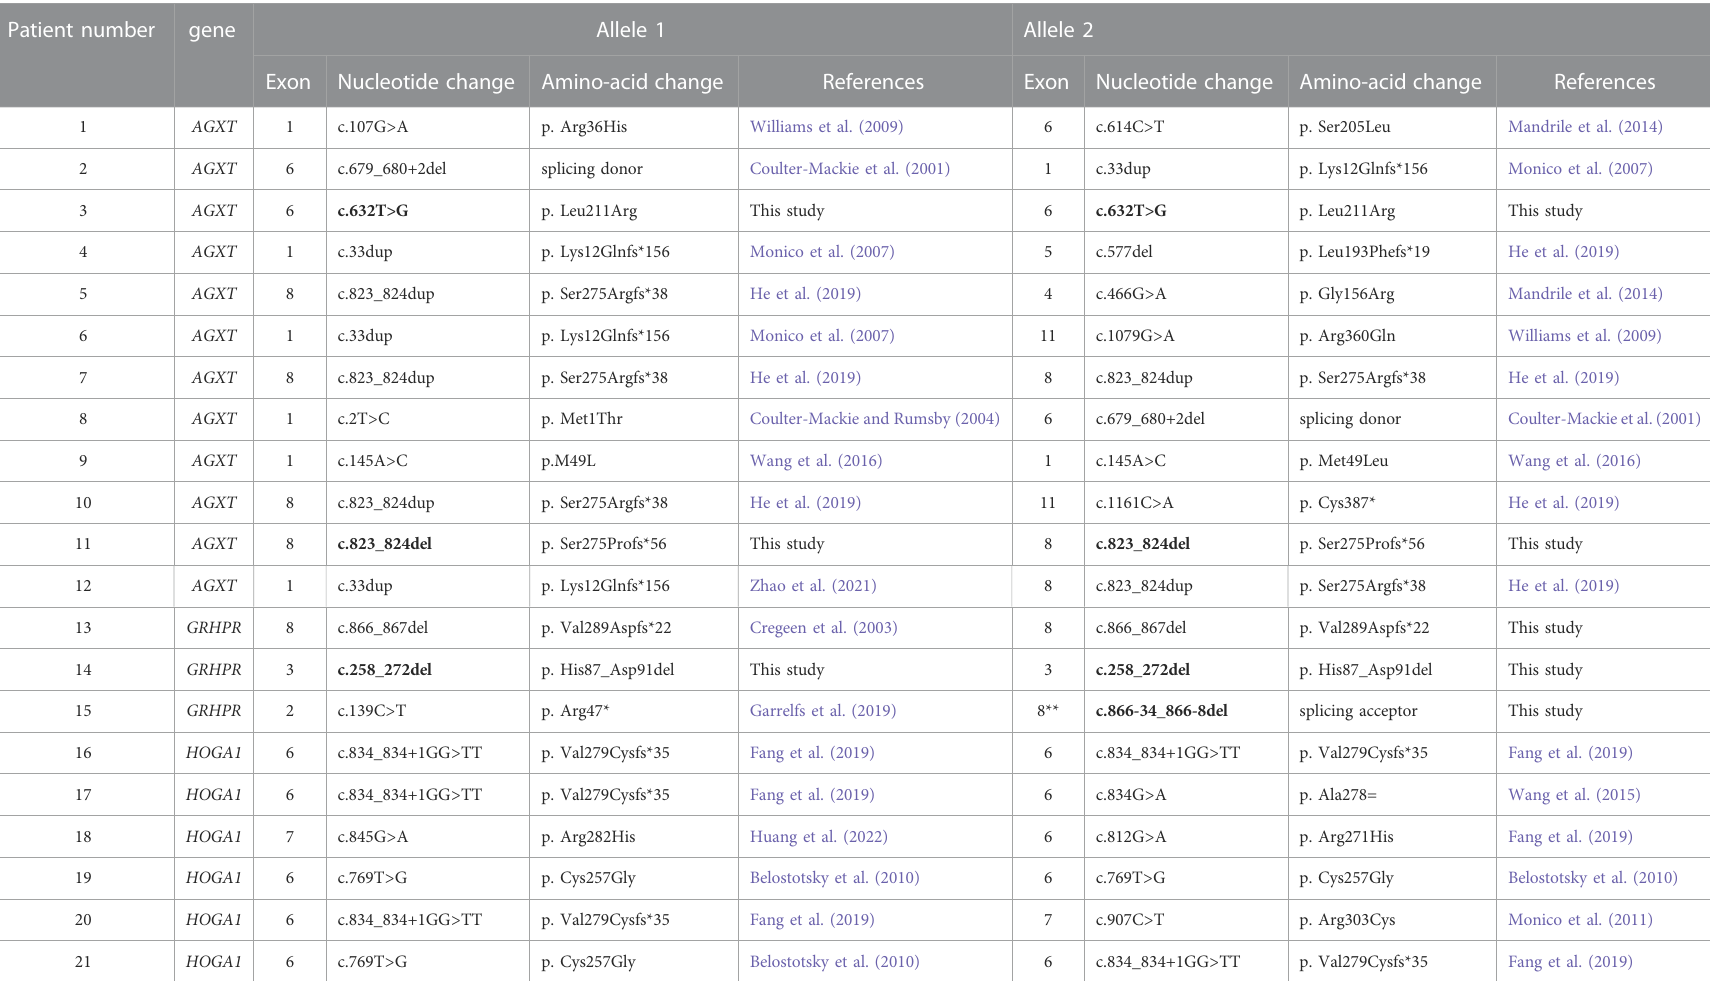
TABLE 1 Pathogenic variants of primary hyperoxaluria that were identi fi ed in this study. Patient